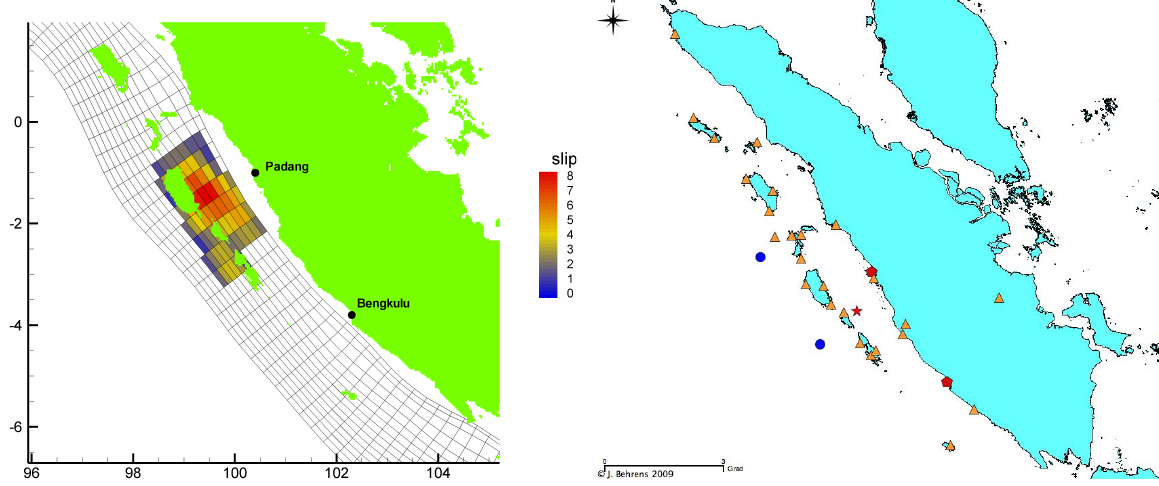
Fig. 7. Bechmark slip distribution (left) and sensor network (right). The two benchmark gauge locations are marked by a red pentagon, and the epicenter location by a red star. Orange triangles indicate GPS stations and blue circles represent the buoy